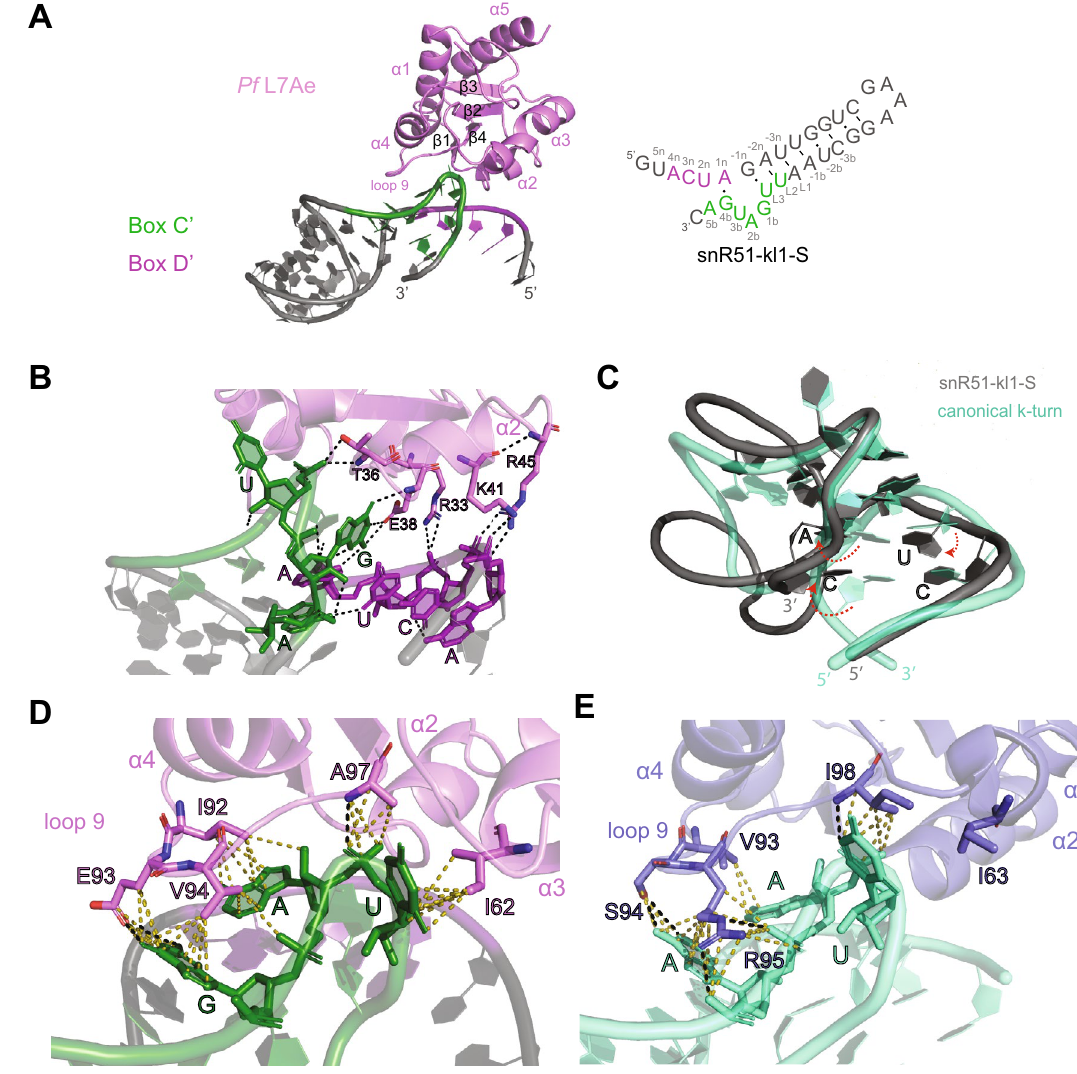
Figure 2. Structure of archaeal L7Ae bound to a eukaryotic non-canonical box C’/D’ motif. ( A ) X-ray structure of Pf L7Ae (pink) bound to RNA snR51-kl1-S (gray), containing the predicted box C’/D’ motif from Sc guide RNA snR51. Predicted box C’ and D’ are colored in green and purple, respectively. The secondary structure of snR51-kl1-S seen in the X-ray structure deviates from the one predicted in Fig. 1B,C and is shown on the right. ( B ) Interaction of the unpaired box D’ (purple) and C’ (green) nucleotides with L7Ae. Polar contacts and hydrogen bonds are represented as black dashed lines. ( C ) Overlay of the kinked structure formed by the non-canonical box C’/D’ motif of snR51-kl1-S (gray) and the canonical k-turn structure formed by a box C/D motif matching the consensus sequence (mint) (PDB code: 1RLG). Differences in the position of the bases and the RNA backbone are marked by red dashed arrows. ( D , E ) Comparison of the interactions of L7Ae ( D ) and Snu13 ( E ) loop 9 amino acids with the snR51-kl1-S RNA (D) and the U4 k-turn RNA ( E ) (PDB code: 1E7K), respectively. Polar interactions and hydrogen bonds are shown as black dashed lines, hydrophobic contacts as yellow dashed lines. In ( D ) box C’ and D’ are colored green and purple, respectively. Structures are displayed with the PyMOL Molecular Graphics System (version 2.0, Schrödinger, LLC; https:// pymol. org/2/). The figure was prepared with Adobe Illustrator (Adobe Inc., 2020/21; https:// adobe. com/ produ cts/ illus